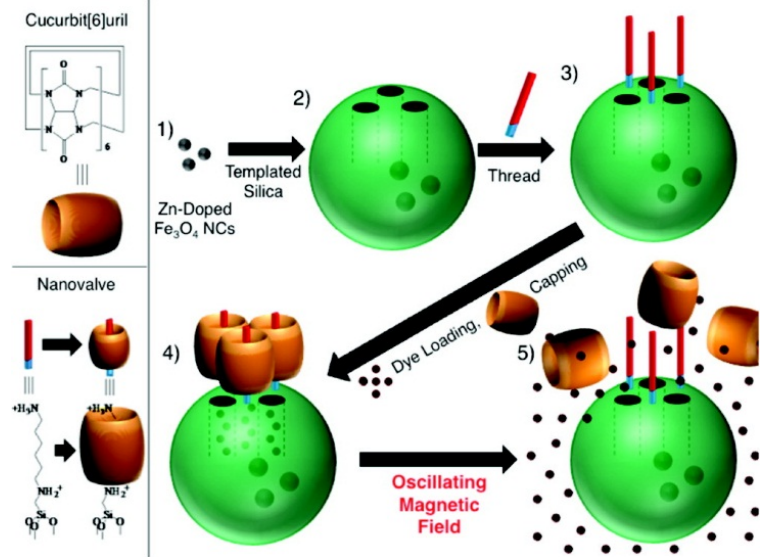
Figure 5. Schematic illustration of the synthesis and operation of a magnet-responsive controlled release system, using ZnNCs encapsulated within MSNs. Reproduced with permission from [72]. Copyright American Chemical Society,